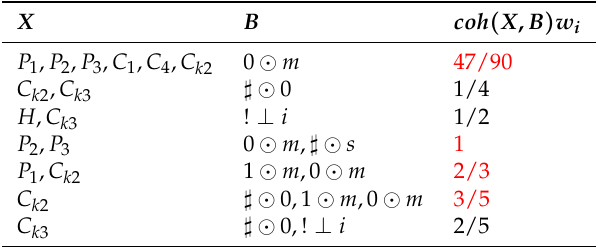
Table 8. The Coh value of a double bond